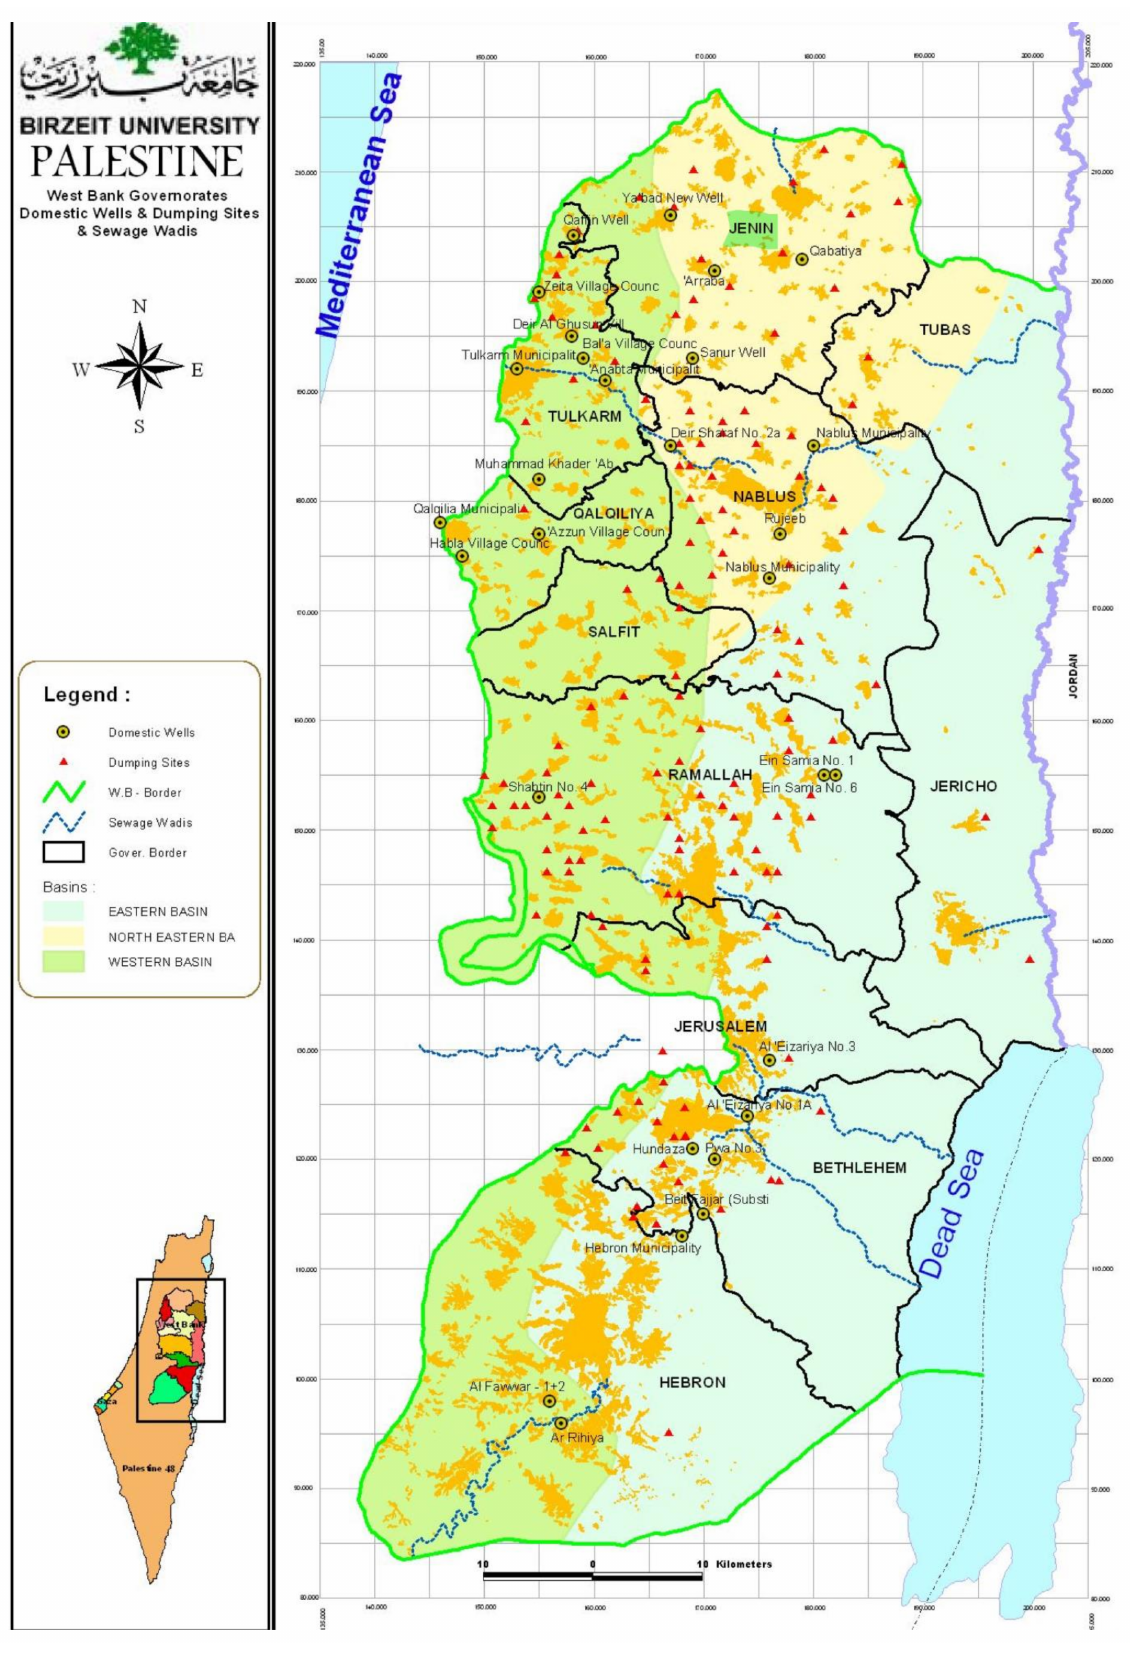
Figure 3. The non-engineered solid waste dumping sites in the West Bank—Birzeit University, Palestine